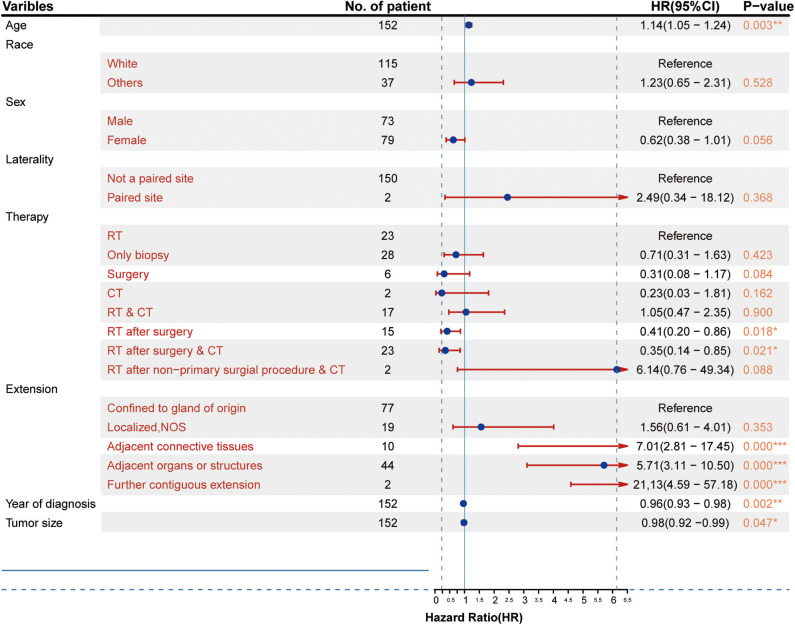
Clinicopathological characteristics of the patients and results of the univariate Cox proportional hazards analysis (HR, 95% confidence interval). *p < 0.05, **p < 0.01, ***p < 0.001.